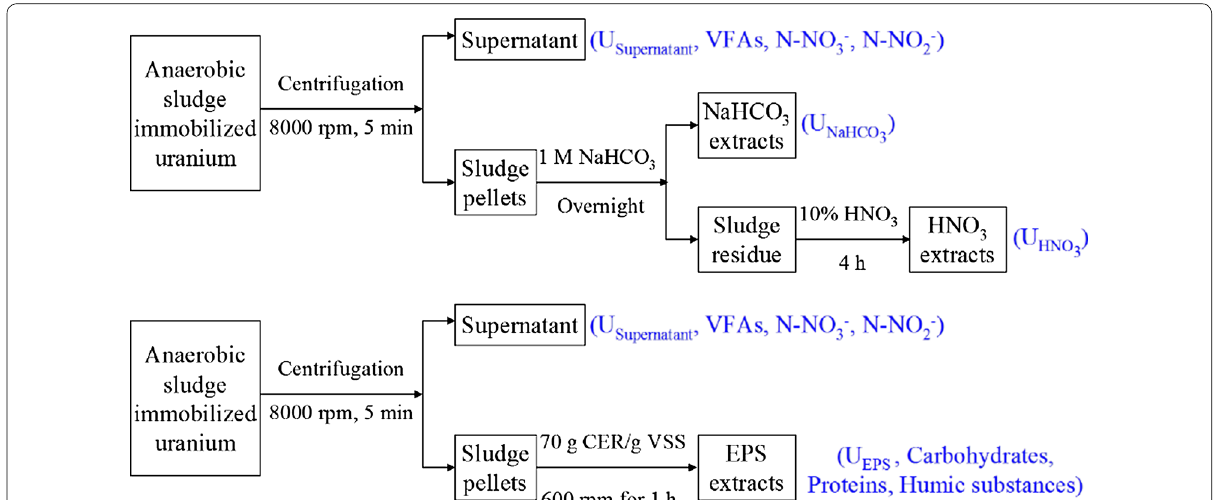
Fig. 1 Schematic diagrams for analyses of U, VFAs, N–NO 3 − and N–NO 2 − in the supernatant, and U in NaHCO 3 –HNO 3 fractionation of sludge; and U, carbohydrates, proteins and humic substances in